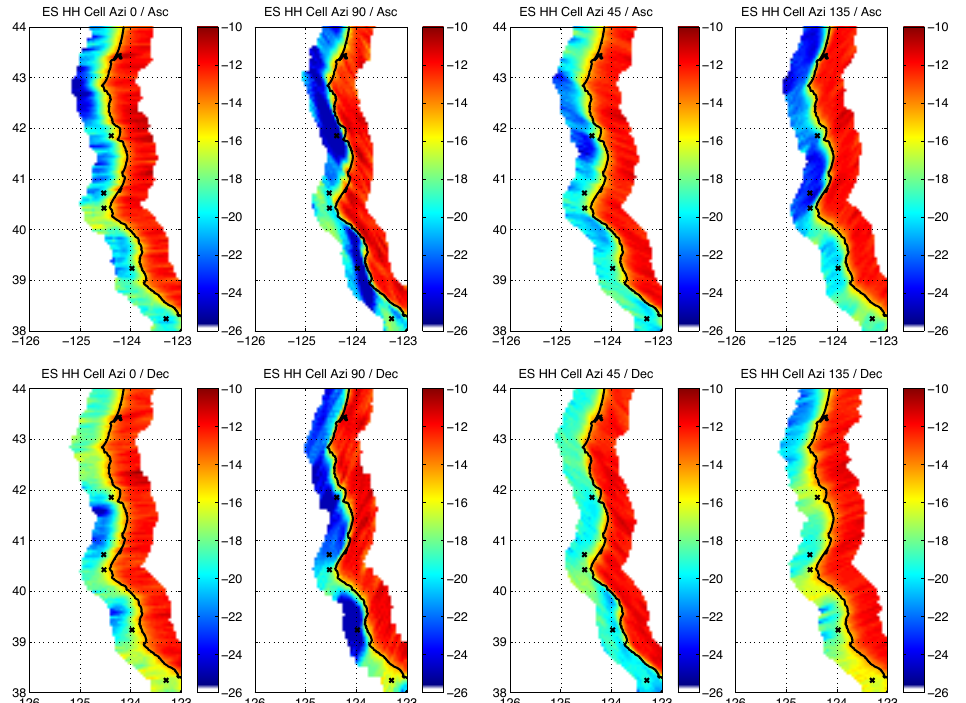
Figure 5. Images of ES for the west coast of United States for December, January, and February 2008. We plot the ES for cell azimuths 0, 90, 45, and 135 (left to right) for ascending (top) and descending (bottom). The slices orientations depend on not only the cell azimuth angle but also ascending / descending since the slices are limited by frequency not range. This plot illustrates the highly variable slice ES as a function of cell azimuth, relative coastline orientation, and ascending / descending. We also show the buoy locations (black x) as well.